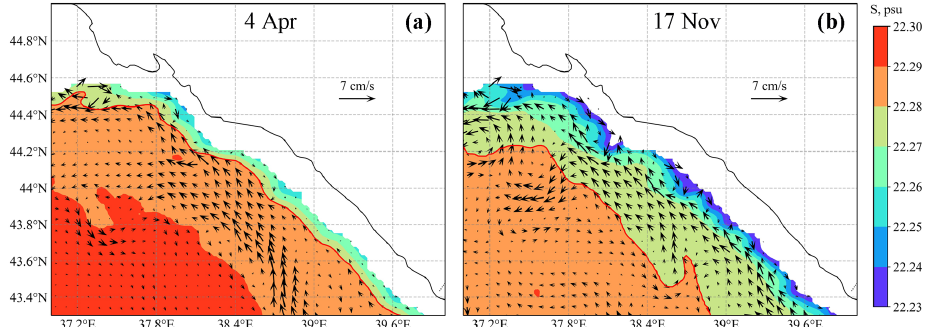
isohaline. (cid:104)